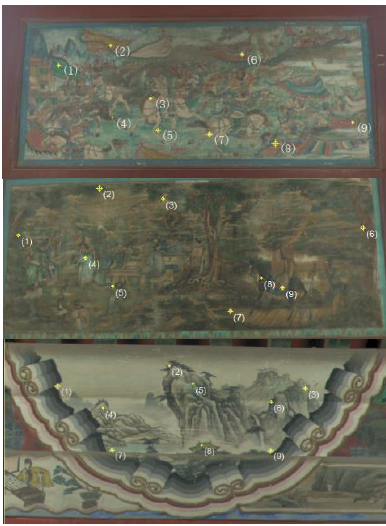
Figure 1. Examples of a colored pattern and sample points location